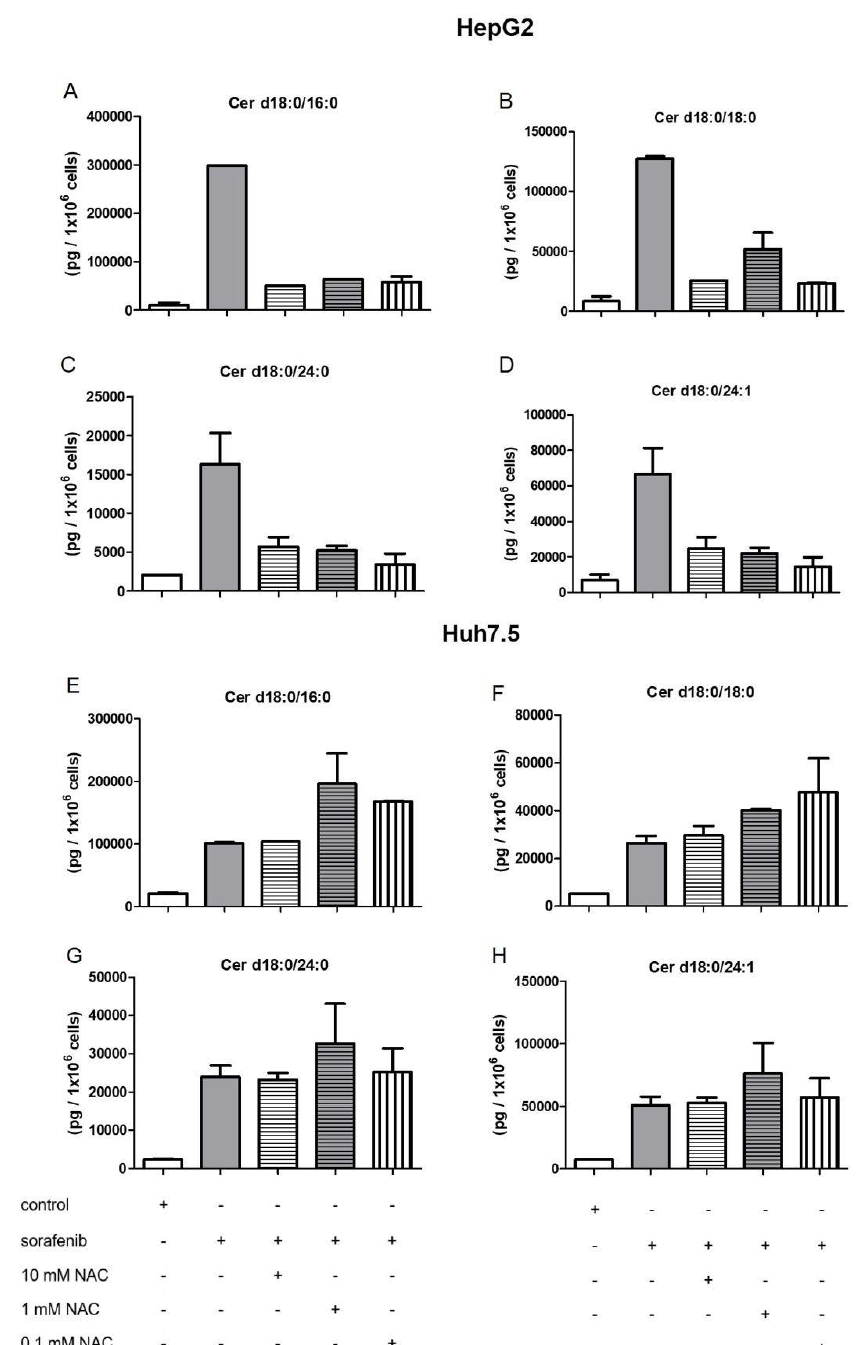
Figure 10. Influence of N-acetyl-cysteine (NAC) on sorafenib-mediated dihydroceramide accumulation of HepG2 and Huh7.5 cells. The lipids were measured by LC-MS / MS. The cells (HepG2 in ( A )–( D ) and Huh7.5 in ( E )–( H )) were treated with 10 mM, 1 mM, or 0.1 mM of NAC for 1 h. Data are derived from 1–2 independent experiments performed in triplicate. For d18:0 / 16:0 in HepG2 cells treated with sorafenib, 10 mM + sorafenib, 0.1 mM + sorafenib. For d18:0 / 16:0 in Huh7.5 cells treated with 10 mM